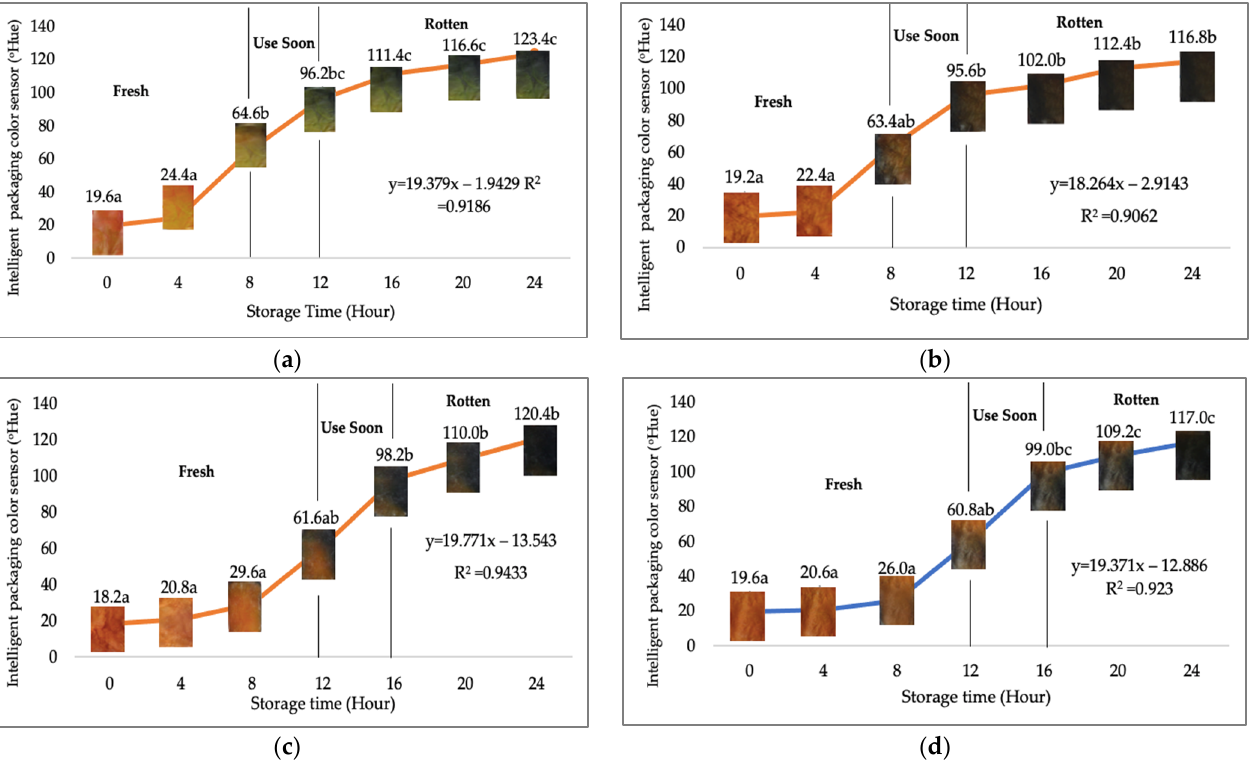
Figure 3. Changes in the color of the BTB solution (pH 2.75) as the intelligent packaging indicator reflecting the freshness of the meat samples packed with the active packaging films with ( a ) 0%; ( b ) 5%; ( c ) 10%; and ( d ) 15% of garlic extract. The mean value followed by different letters showed a significant difference based on the Duncan’s test at the 5% level ( p -value < 0.05).